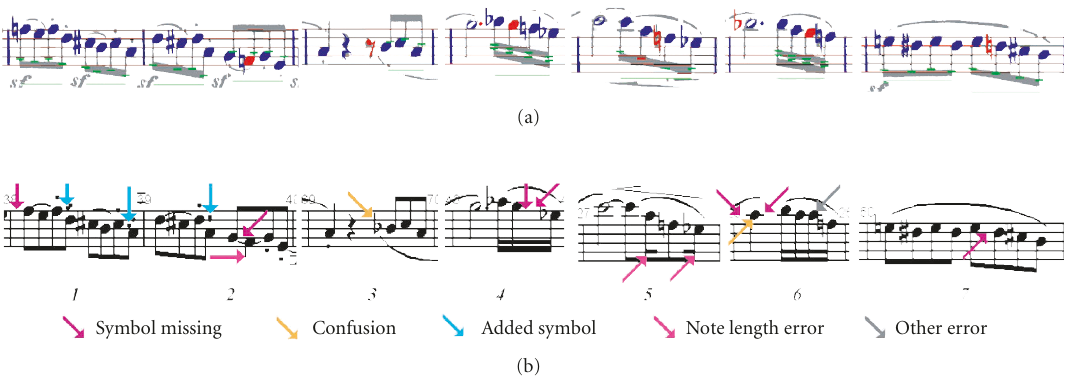
Figure 19: Comparison with the commercial software SmartScore [4]. (a) Results with our method: 0 error. (b) Results with SmartScore: 16